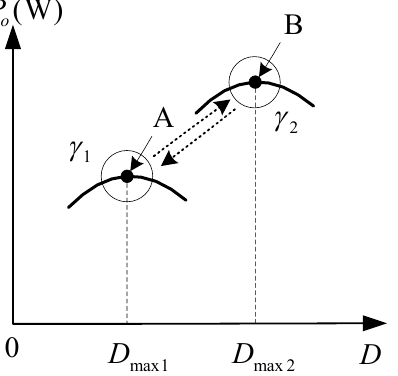
Figure 9. Regularity under (2), (5), (7) or (8) conditions. Table 6. Eight operating conditions of PV